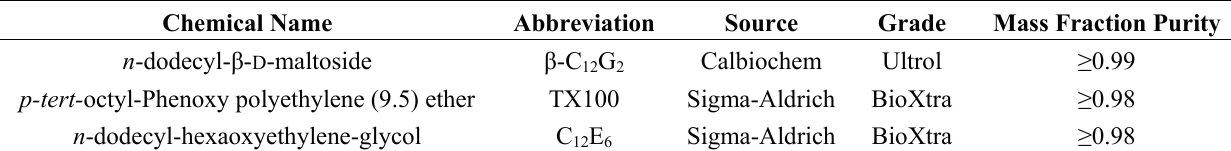
Table 4. Surfactants used in the present